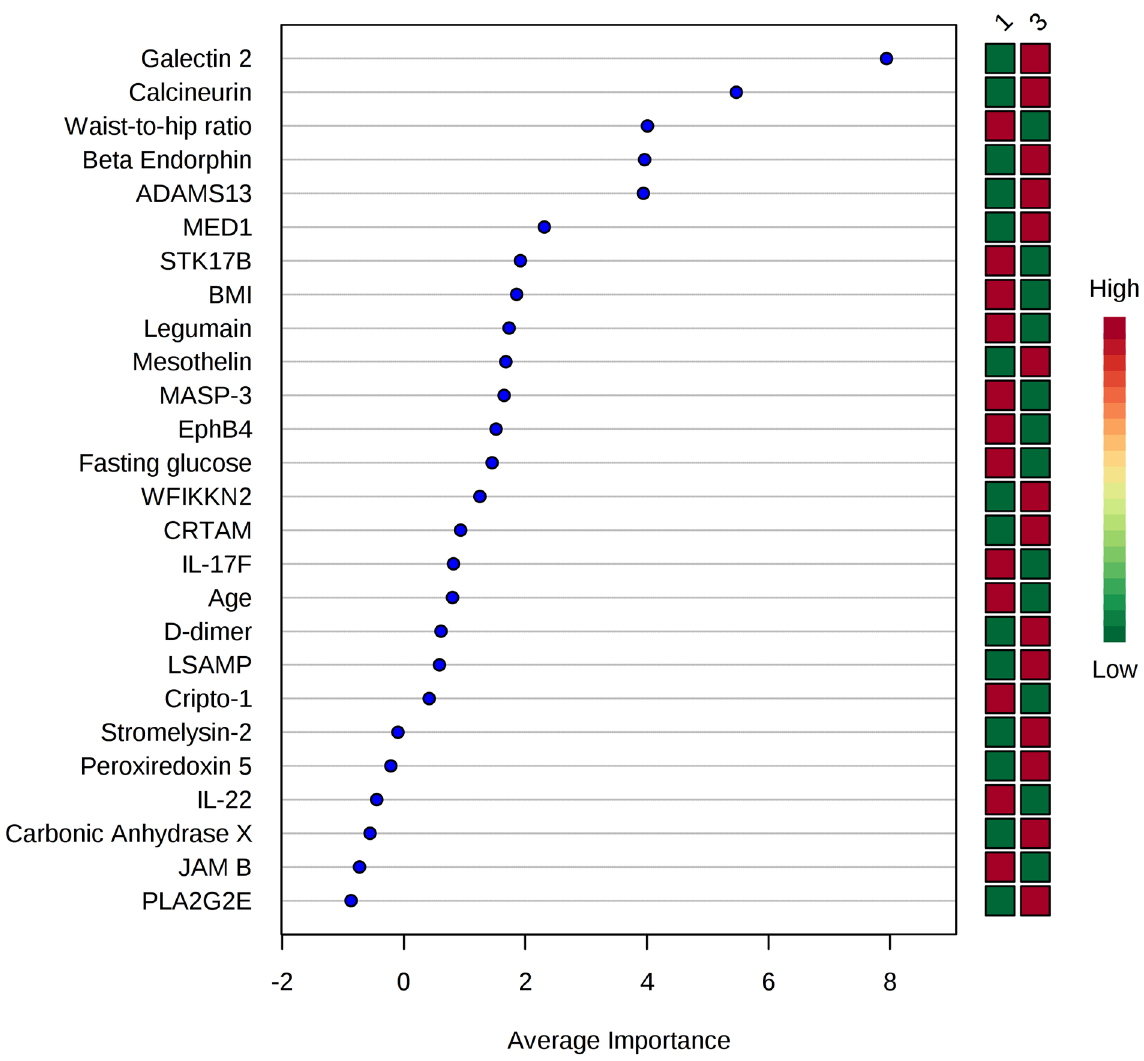
Fig 2. Features ranked by mean importance measure for the ROC curve analysis for beta-cell function/HOMA-IR. Determination of the predictive ability of the protein panel (22 proteins associated with beta-cell function/HOMA-IR (p (cid:20) 0.01)), age, BMI, waist to hip ratio and fasting glucose, for discrimination between low and high beta-cell function/HOMA-IR values of MECHE participants (n = 30). Par scaling was used and random forest classification method was selected. Using all 26 variables, the best ROC curve was produced with an AUC of 0.913. AUC: area under the curve. 1 : Tertile 1- low beta-cell function 3: Tertile 3- high beta-cell function. Green filled square: Low concentration/value Red filled square: High concentration/value Green filled square/ Red filled square: Positive association with beta-cell function/HOMA-IR Red filled square/Green filled Square: Inverse association with beta-cell